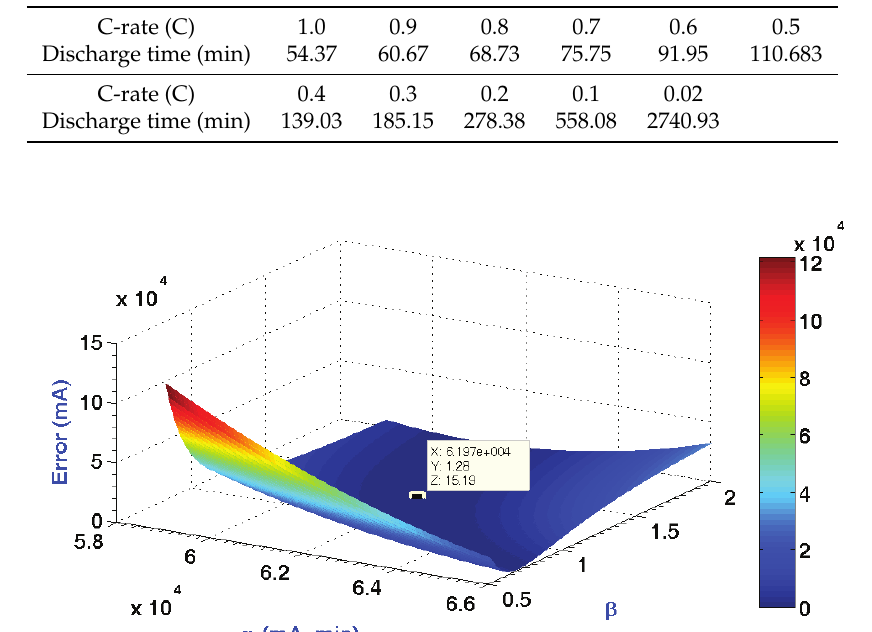
Figure 10. Error surface to find the optimization set of the α and β